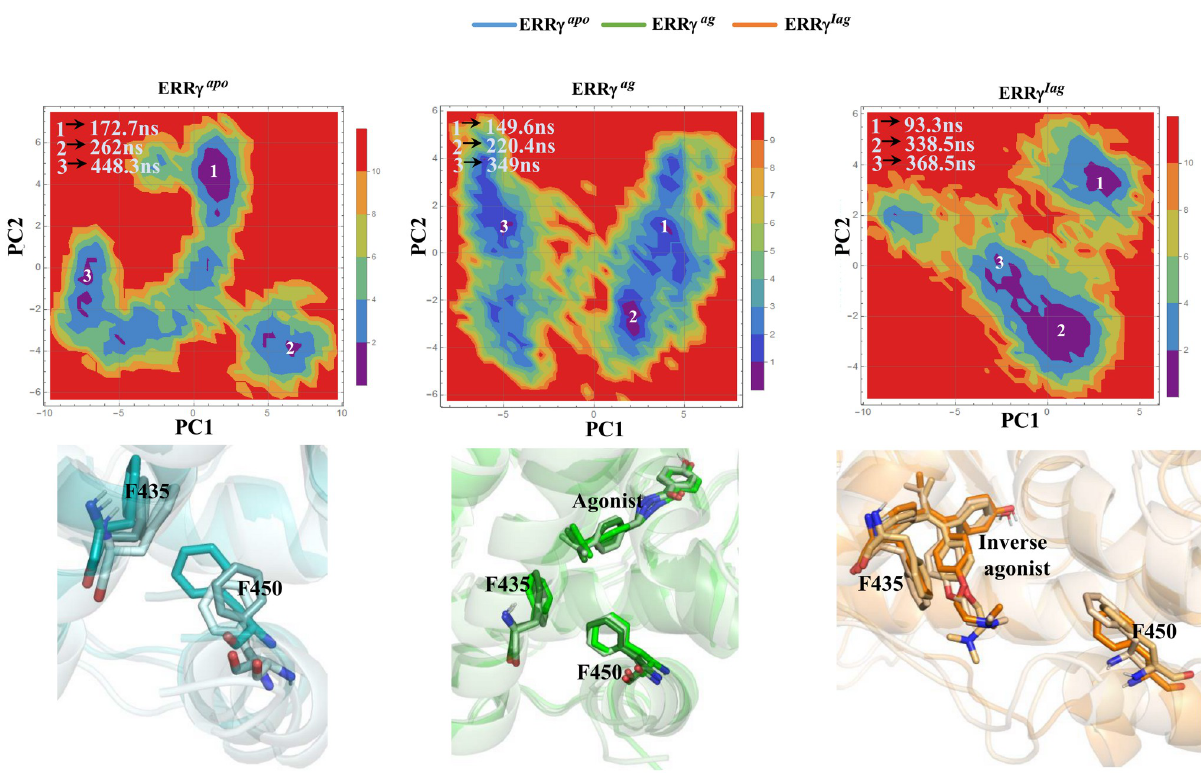
Fig 7. Free energy landscape of ERR γ apo , ERR γ ag and ERR γ iag : 2D projection of free energy landscapes of ERR γ apo , ERR γ ag and ERR γ iag as a function of PC1 and PC2. The lowest point of the free energy reservoir shown in blue and violet represents the energy minima. The representative structures from each cluster of FEL were extracted and superimposed to show the variations in the AF-2 helix region. Residues F435, F450 and ligands are represented in the stick model.